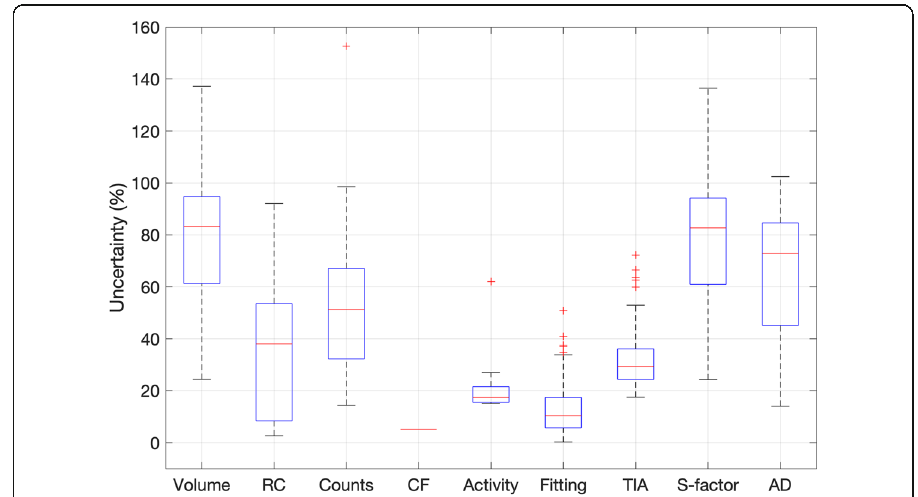
Fig. 2 Distribution of uncertainty (%) for each step of the absorbed dose calculation